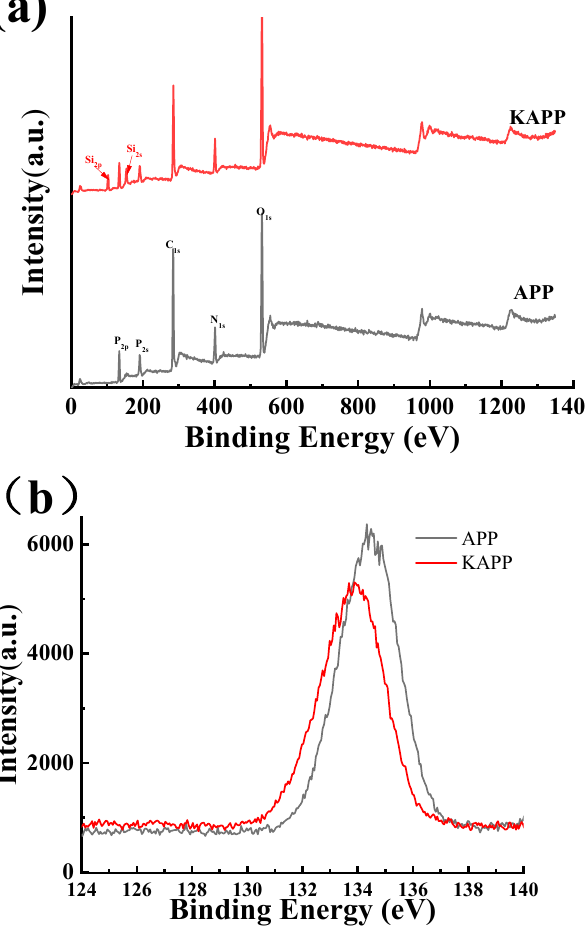
Figure 7. XPS profiles of APP and KAPP all elements ( a ) and P 2p ( b ). Also, as per Figure 7b, the binding energy of P 2p in the modified KAPP was lower than that of P 2P in the unmodified APP. This result indicates that a chemical reaction occurred between APP and KH-550 during the modification process and that chemical binding state of the surface P elements had changed. The inference is that the P-O-N portion of the powder particle surface changed to P-O-Si, and as Si element has a lower electronegativity, the binding energy of P-O-Si is lower than that of P-O-N, This phenomenon resulted in, a change in the binding energy of P 2P in KAPP. To verify this inference, a split-peak fitting process for the P elements in APP and KAPP was performed, and the results from the fitting are presented in (Figure